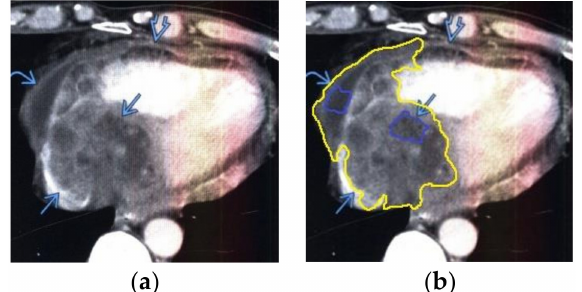
Figure 8. Heart MRI: ( a ) image with white noise and ( b ) denoised image with contrast enhancement of lymphoma in the right atrium.